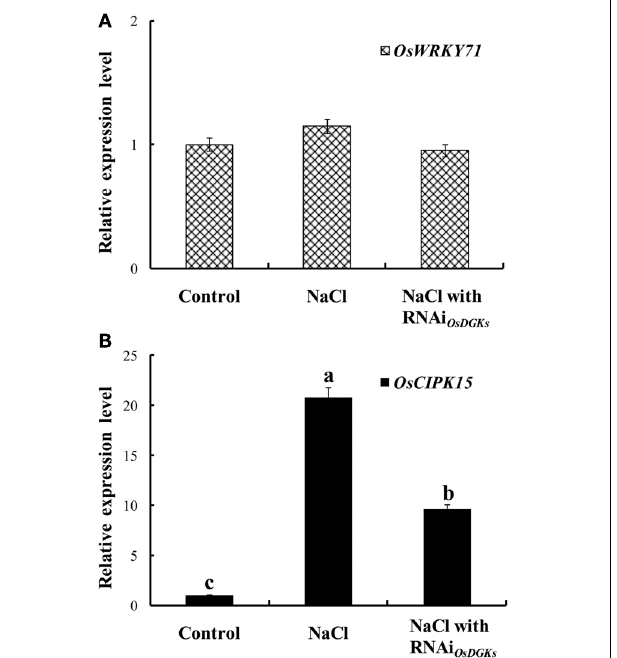
FIGURE 7 | Effects of silencing of OsDGKs on OsWRKY71 and OsNPR1 transcription induced by xylanase in rice protoplasts. After transient RNAi using two in vitro -synthesized dsRNAs against conserved regions of OsDGK ( 1 , 2 , 3 , 7 ) and OsDGK ( 4 , 5 , 8 ) for 24h, the transfected protoplasts were treated with 150 μ g/ml xylanase for 6h.The protoplasts were collected for real-time PCR analysis to detect transcripts of OsWRKY71 (A) and OsNPR1 (B) .Values followed by different letters differ significantly ( P < 0.01).